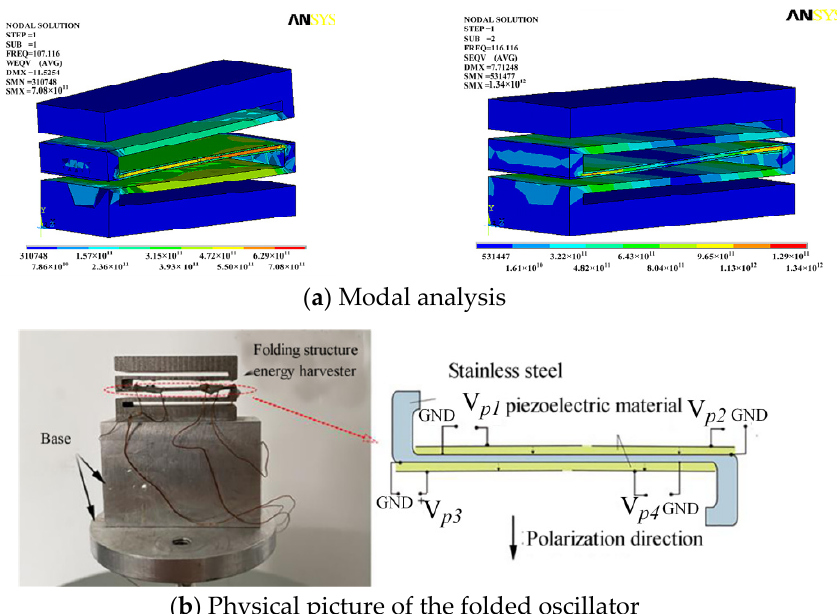
Figure 5. Folded structure piezoelectric energy harvester.